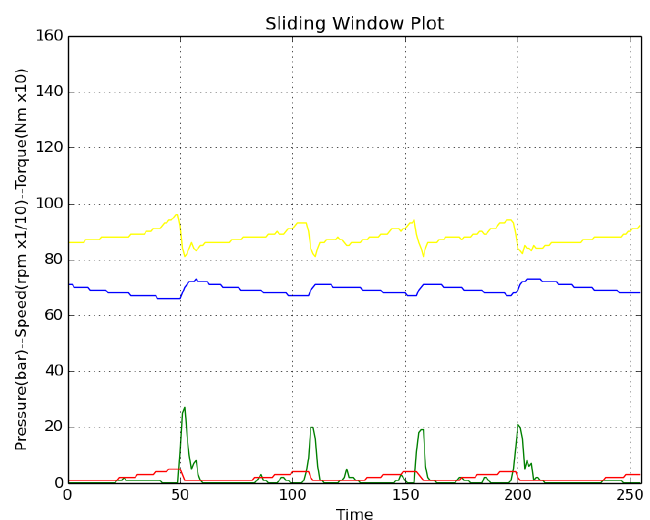
Figure 19. Pressure loop at 70 bar with an inefficient pump.